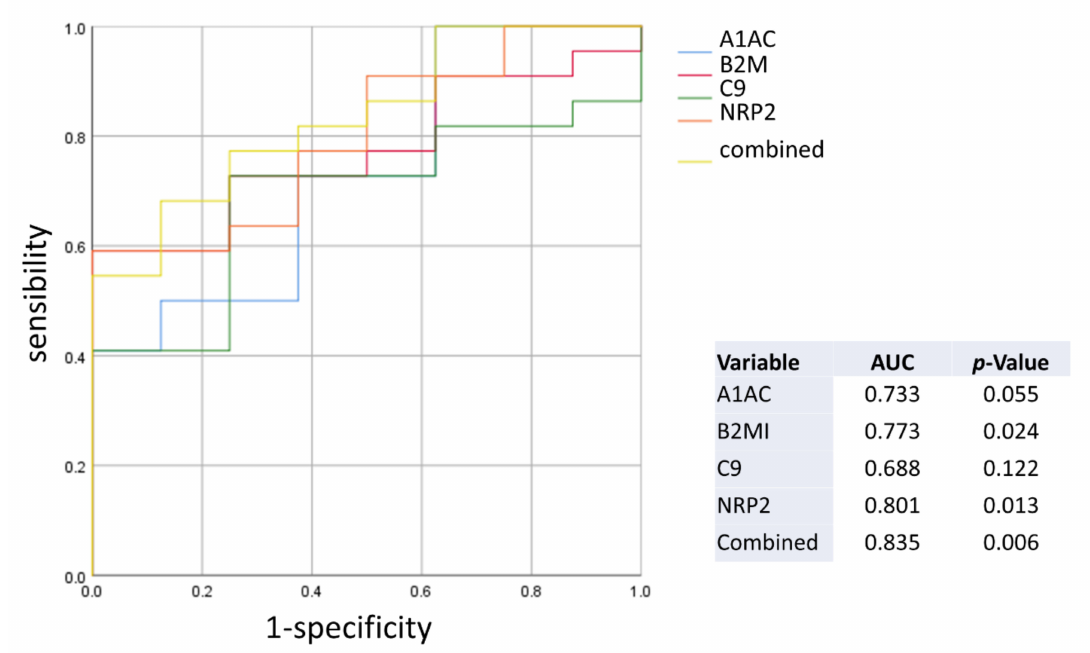
Figure 4. ROC generated with the selected features.